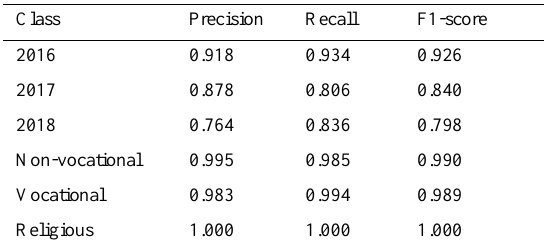
Table 8. Weight model performance (λ = 0.02) on test dataset